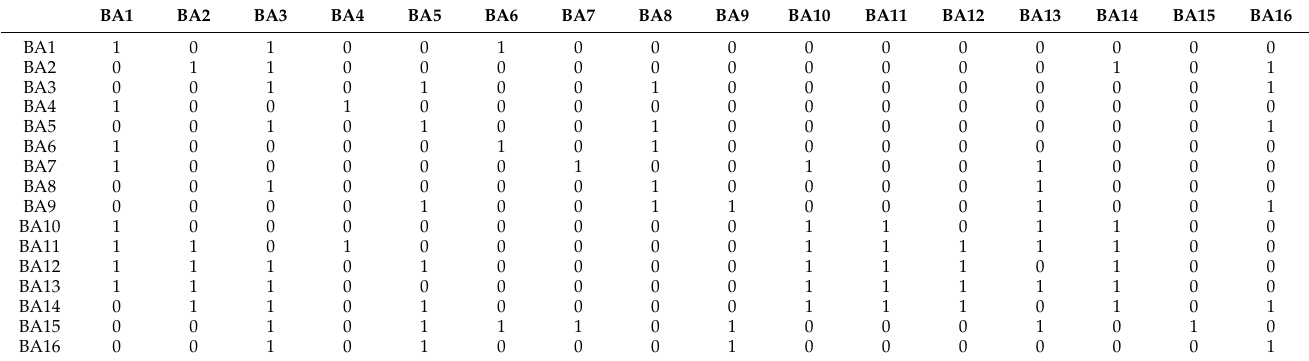
Table 6. Initial reachability matrix of the barriers as derived from the SSIM prior to transitivity.